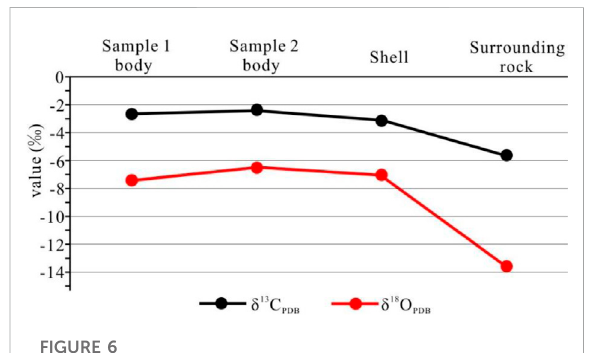
FIGURE 6 Comparison of δ 13 C carb and δ 18 O carb values of carbonates at different locations.